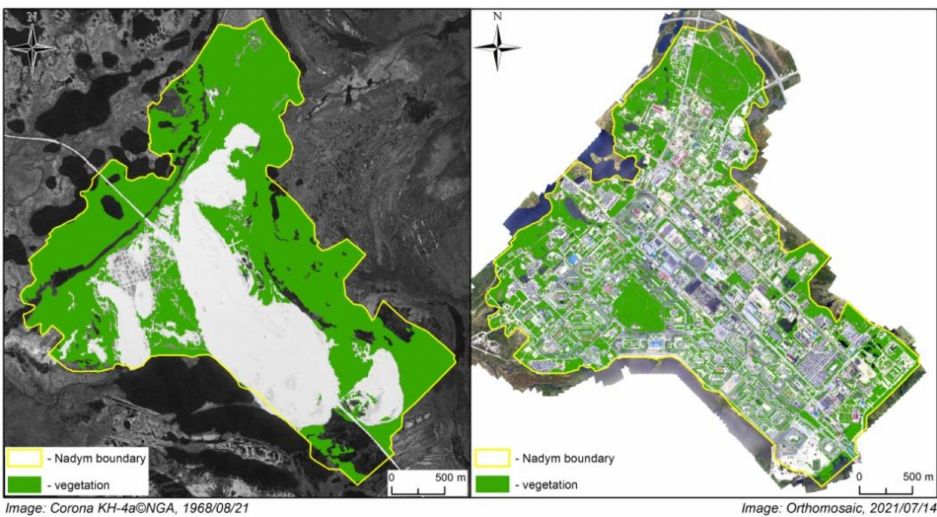
Figure 5. Green space distribution in 1968 and